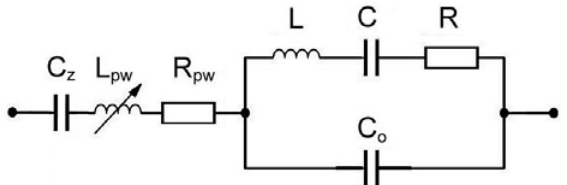
Figure 1. Load capacitance C with the quartz crystal equivalent